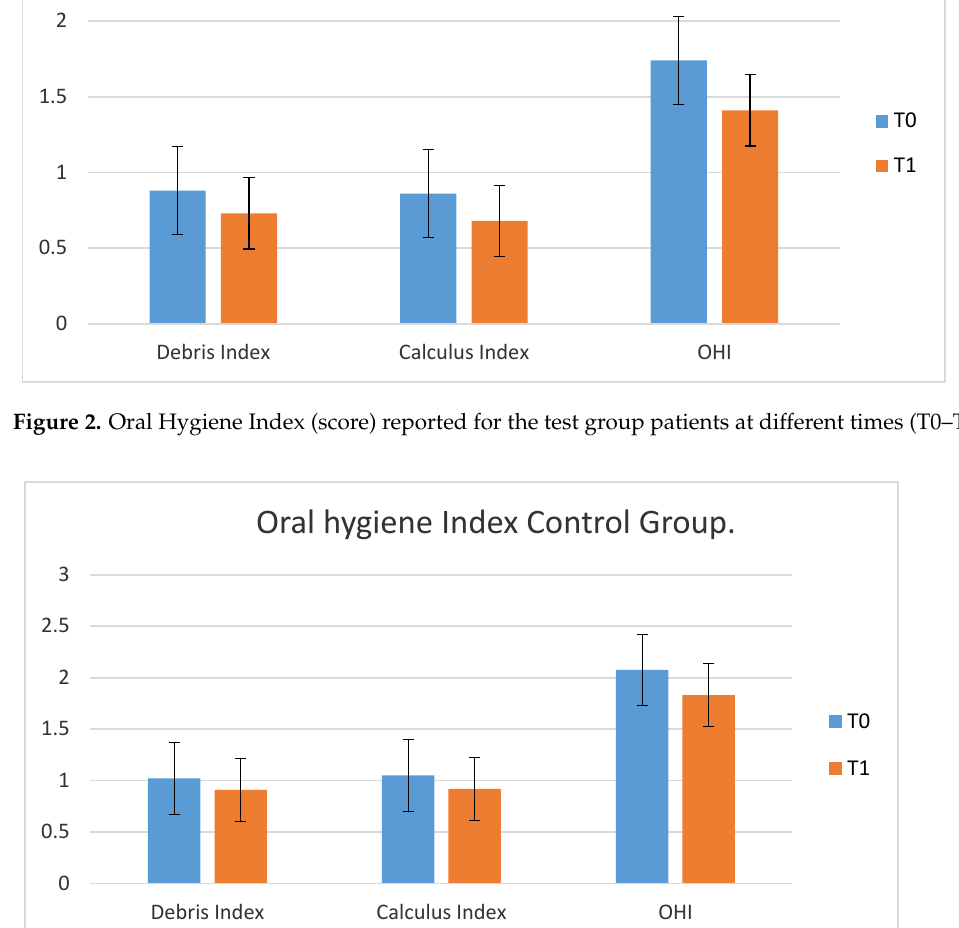
Figure 3. Oral Hygiene Index (score) reported in the control group at different times (T0–T1).